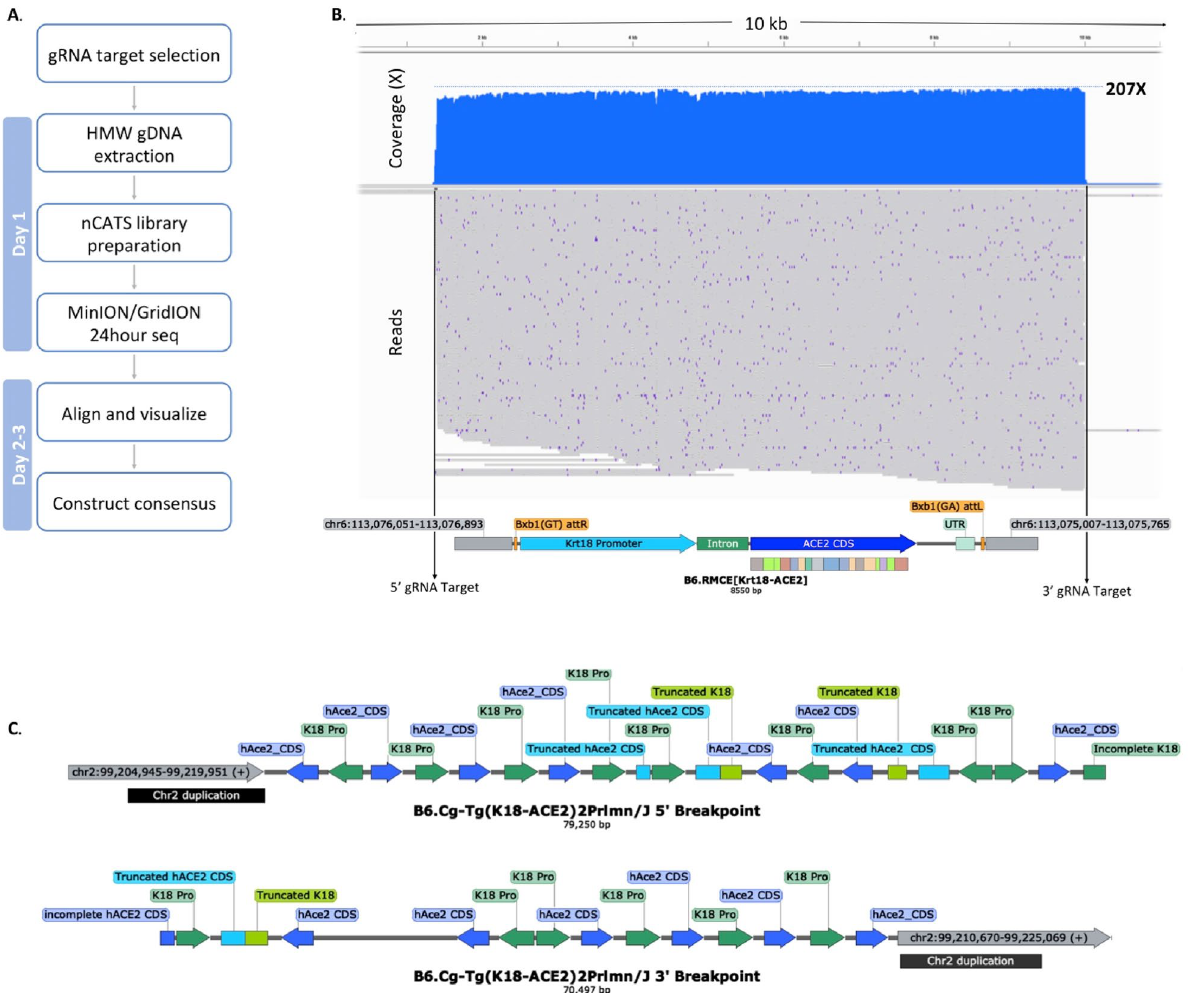
Figure 6. Characterization of transgenic mice using nCATS. ( A ) Post sequencing workflow to construct insert regions and identify genomic locations. ( B ) nCATS characterization of B6.Cg-Tg(Krt18-ACE2) allele generated using the Bxb1 Int to achieve single copy integration, 215 reads on-target generating 195X coverage across the entire 8.5 kb insertion site and 900/800 bp genomic breakpoints. ( C ) nCATS characterization B6.Cg-Tg(K18- ACE2)2Prlmn allele, 5’ and 3’ breakpoints identified at least 11 copies of K18-ACE2 in varying